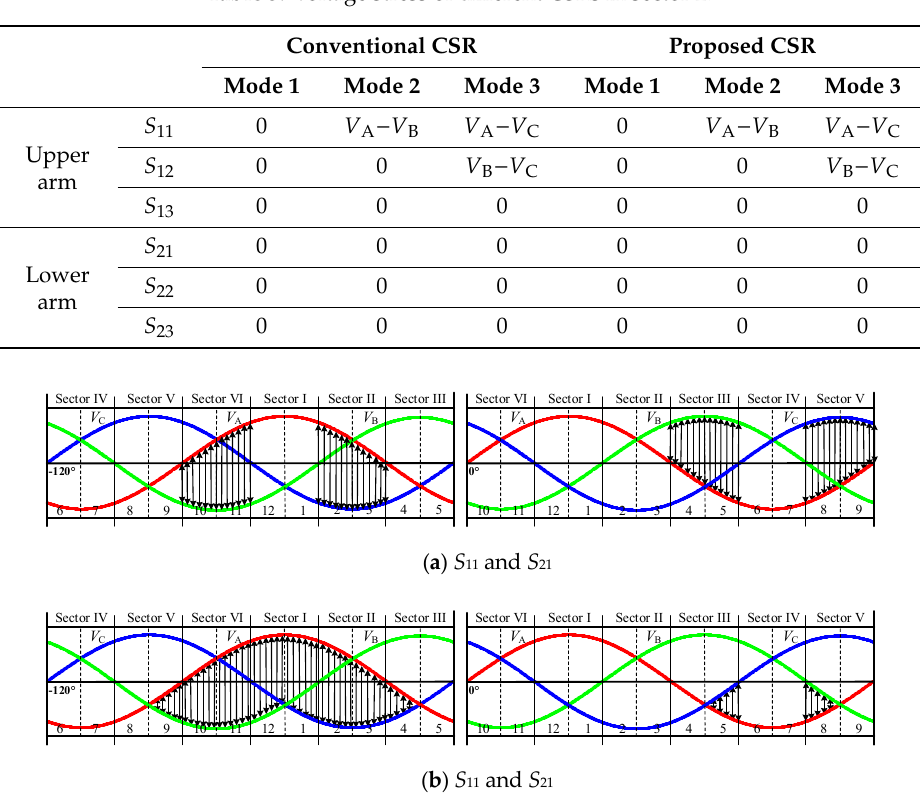
Table 3. Voltage stress of different CSRs in sector 2.